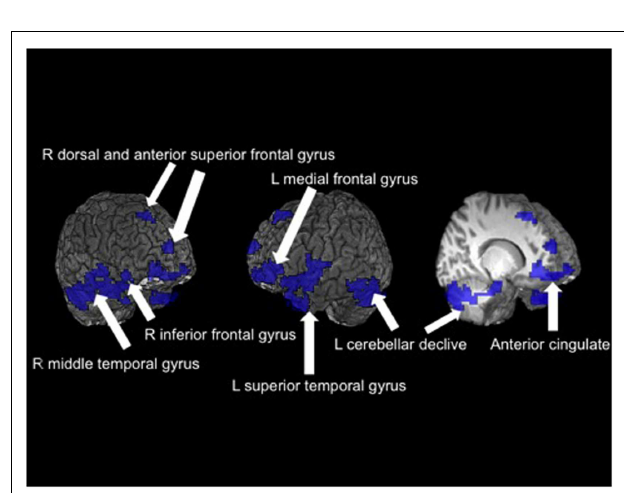
FIGURE 3 | Significant fMRI clusters predicted by the interaction between gender and binge-drinking status ( N = 95) . Areas in blue indicate where female binge drinkers demonstrated significantly reduced BOLD response during the spatial working memory task compared to female controls, while male binge drinkers demonstrated increased BOLD response (adapted from Squeglia et al., 2011).